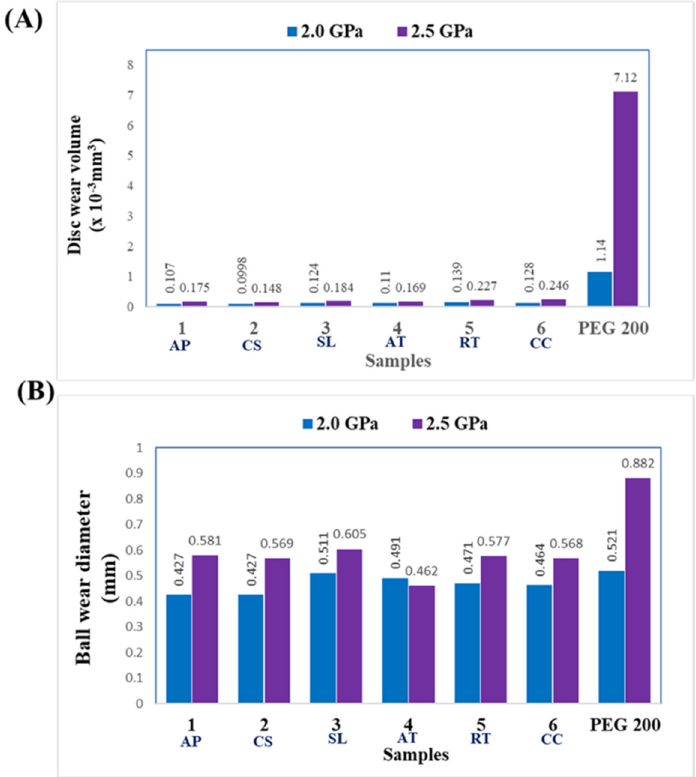
Figure 8. Performance indicators showing ( A ) disc wear volume and ( B ) ball wear diameter while using PEG 200 or microbial fatty acids as lubricants at loads of 2.0 GPa and 2.5 GPa, over a test duration of 1 h, and at room temperature.